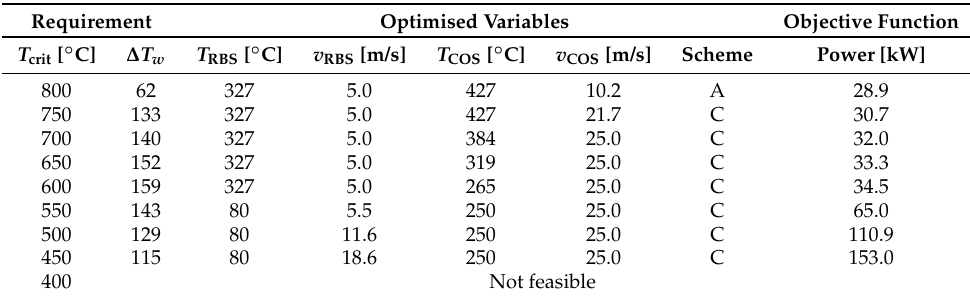
Table 5. Window cooling optimisation